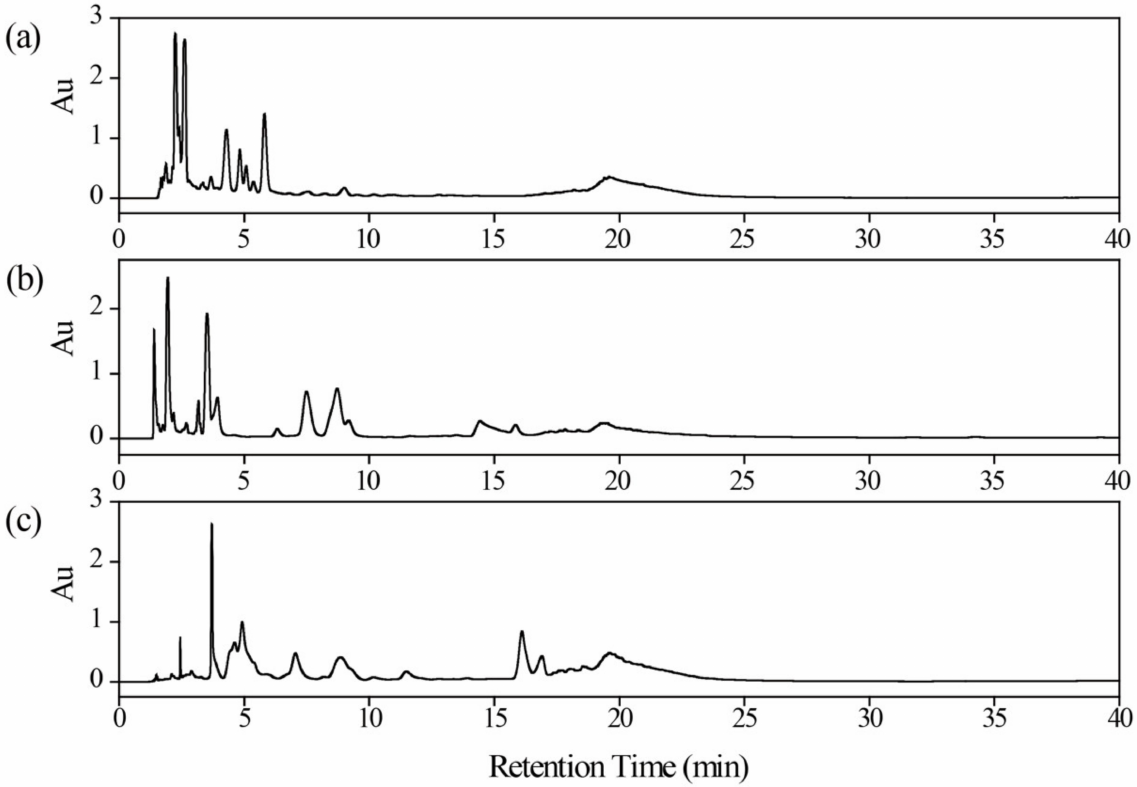
Figure 2. RPLC chromatograms of polar fraction at 254 nm on ( a ) XBridge column (150 × 4.6 mm i.d., 5 µ m), ( b ) XCharge C18PN column (150 × 4.6 mm i.d., 5 µ m) and ( c ) XAqua C18 column (150 mm × 4.6 mm i.d., 5 µ